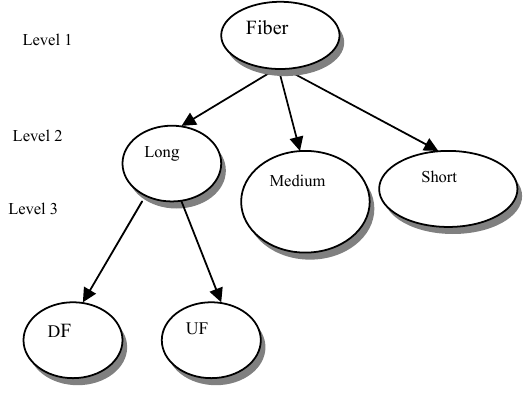
Figure 4: Decision Tree